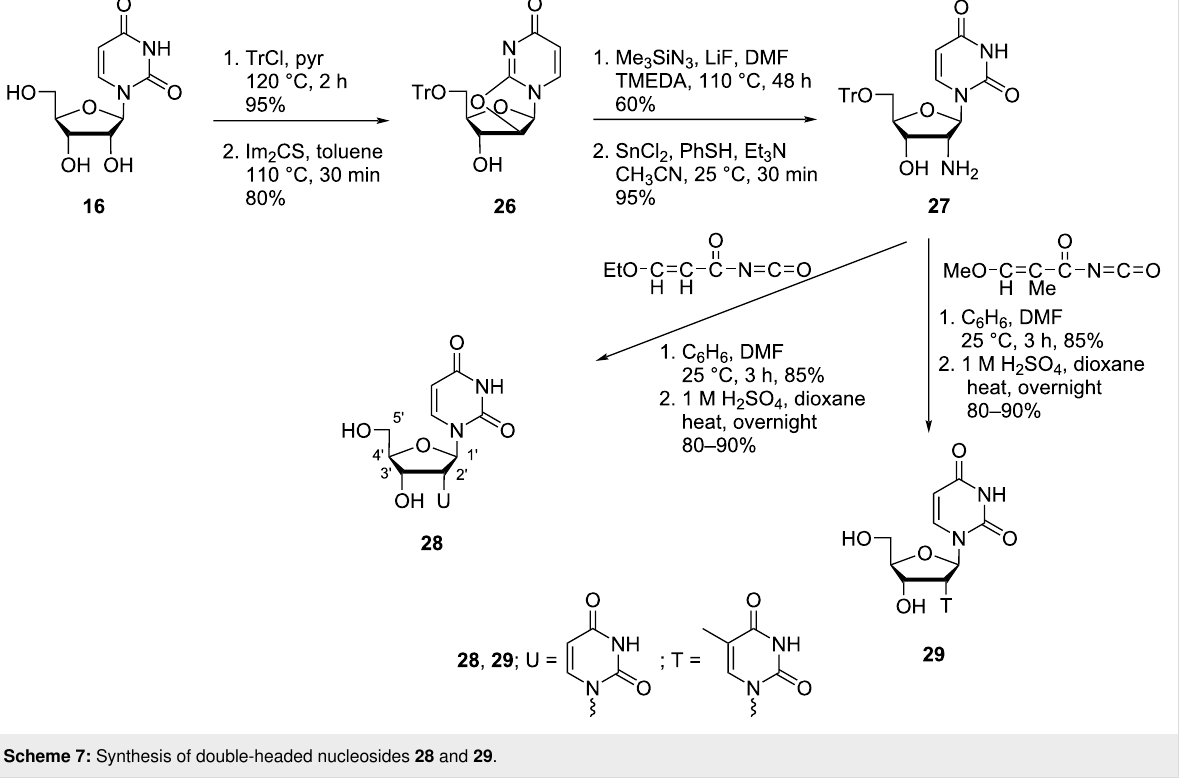
Scheme 7: Synthesis of double-headed nucleosides 28 and 29 .